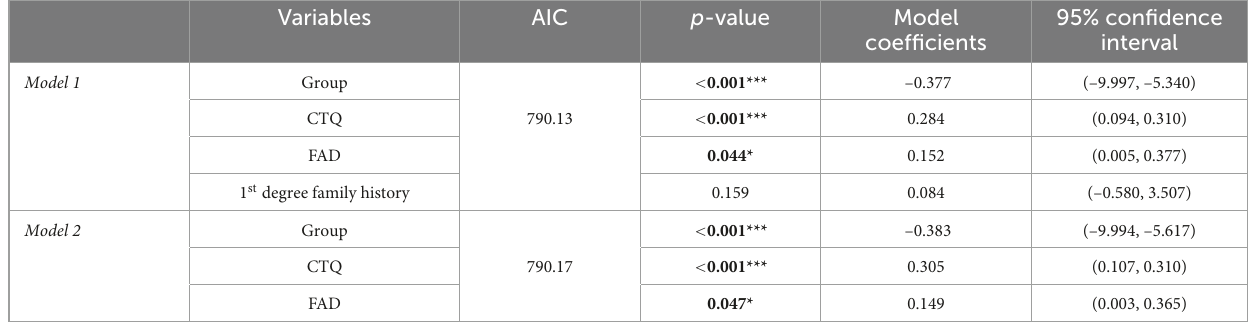
TABLE 5 Best model selection: significance of the predictors on YSR.